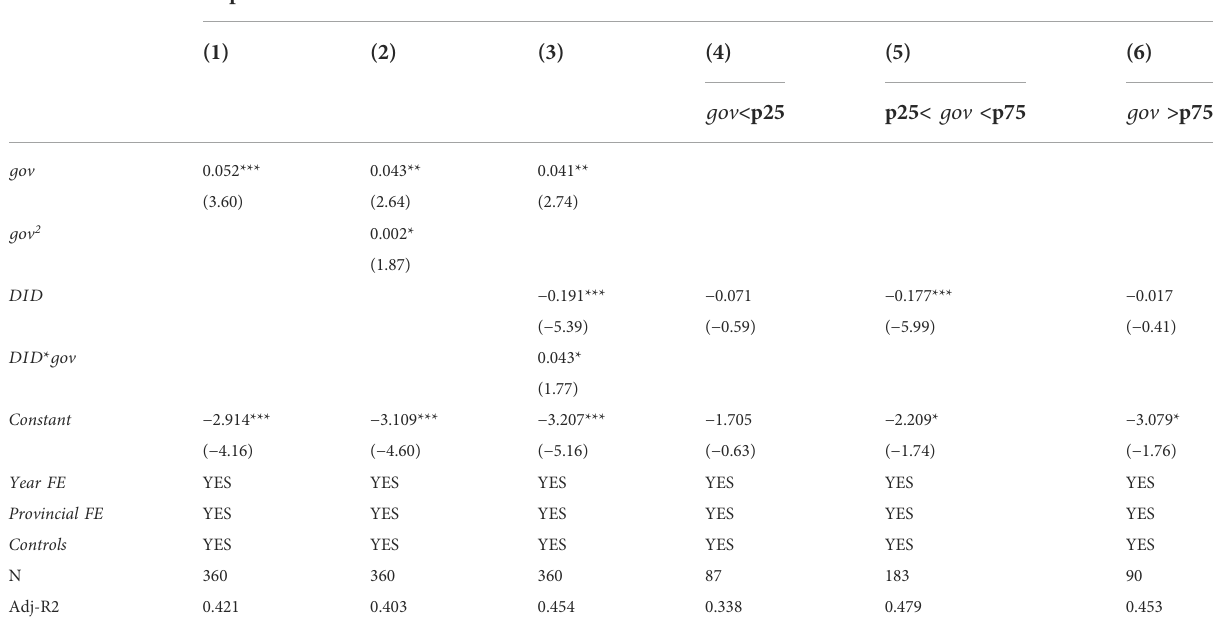
TABLE 7 Test of synergy of government